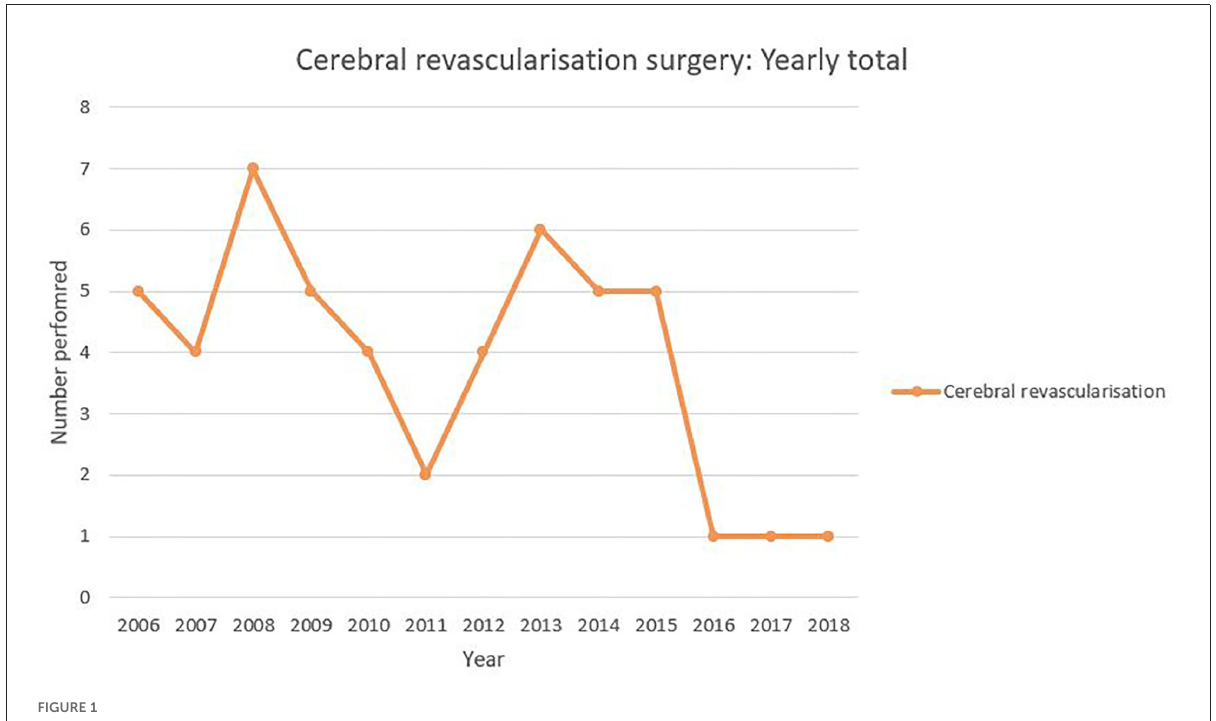
FIGURE1 Yearly incidence of cerebral revascularization